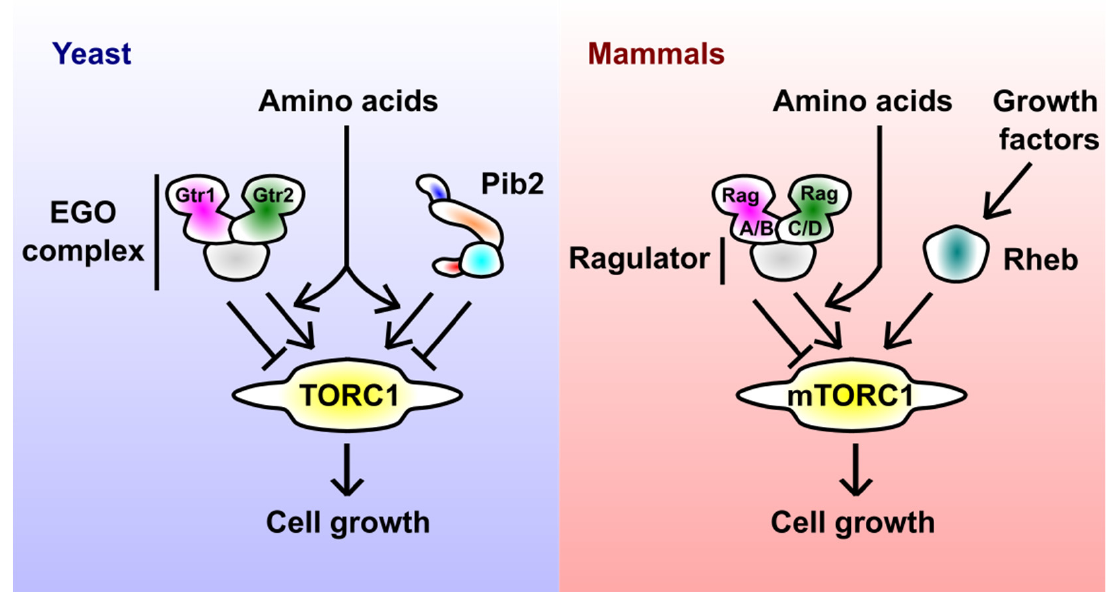
Figure 1. Major regulators of yeast and mammalian TORC1. In yeast, amino acids activate TORC1 via the EGO complex (consisting of the Gtr1-Gtr2 small GTPase heterodimer and scaffolding subunits) and Pib2. The schematic representation of Pib2 reflects its domain structure (see Section 5 for details). In mammals, amino acid and growth factor signals to mTORC1 are mediated by the Rag-Ragulator complex (the EGO complex equivalent) and Rheb small GTPase, respectively.